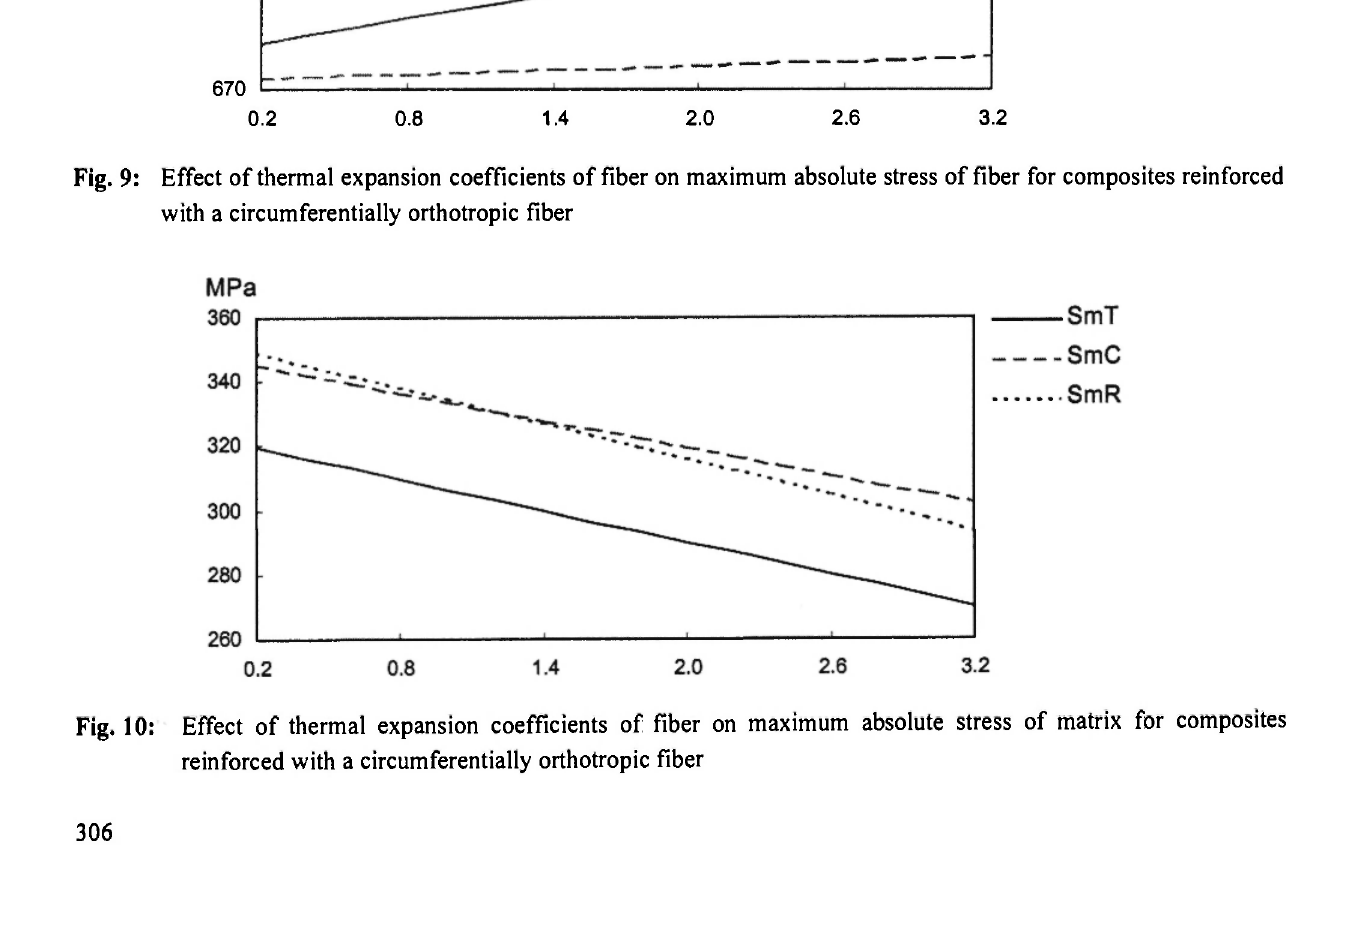
Fig. 10: Effect of thermal expansion coefficients of fiber on maximum absolute stress of matrix for composites reinforced with a circumferentially orthotropic